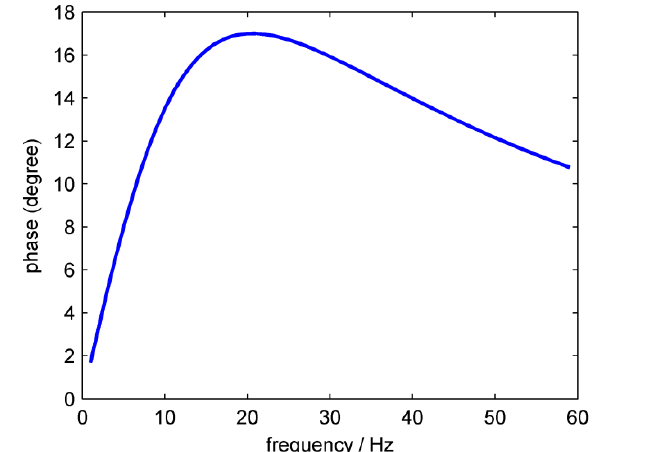
Figure 6. The test signal, ∆𝐼 the generators.